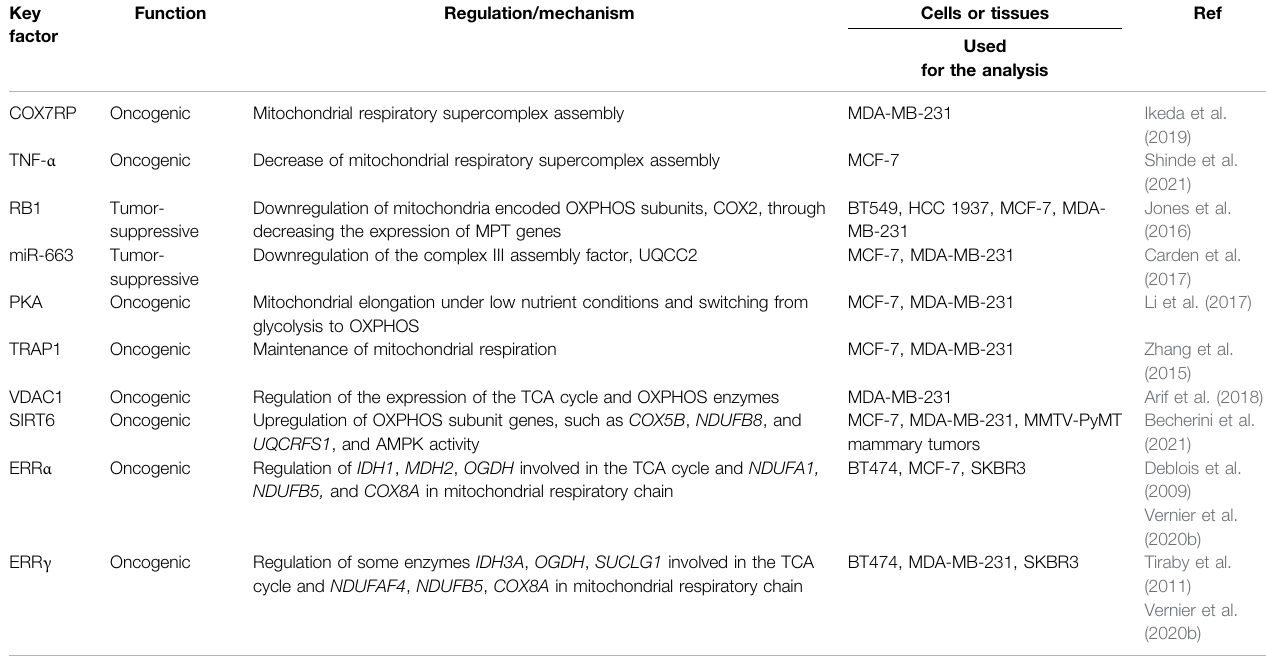
TABLE 1 | Regulation of mitochondrial respiratory supercomplex and oxidative phosphorylation (OXPHOS) in breast cancer